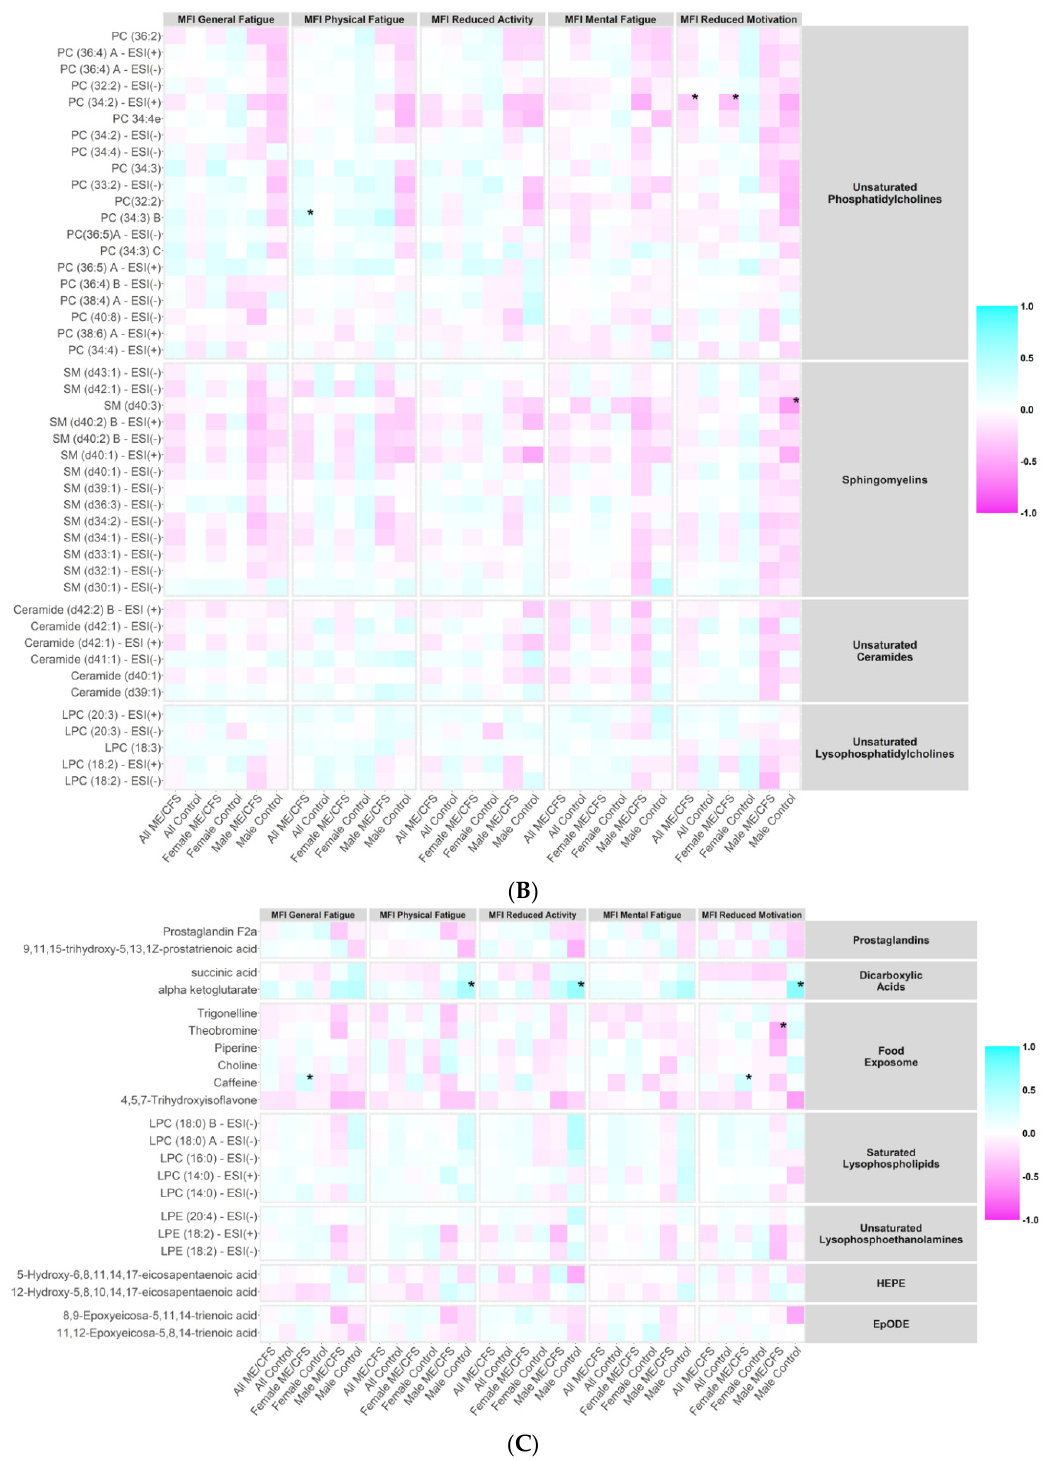
Figure 4. Correlation heatmap. MFI, Multidimensional Fatigue Inventory scored on 0–100 scale with 0 = no fatigue and 100 = maximal fatigue. ME/CFS: myalgic encephalomyelitis/chronic fatigue syndrome. * p < 0.01. Heatmap showing the correlation coefficients between the plasma levels of metabolites in the metabolic clusters that were significantly altered in ME/CFS (bold in Supplementary Table S4) and MFI scales using Spearman’s correlation tests in all ME/CFS, all controls, female ME/CFS, female controls, male ME/CFS, and male controls. ( A ) Correlation heatmap, part 1. ( B ) Correlation heatmap, part 2. ( C ) Correlation heatmap, part